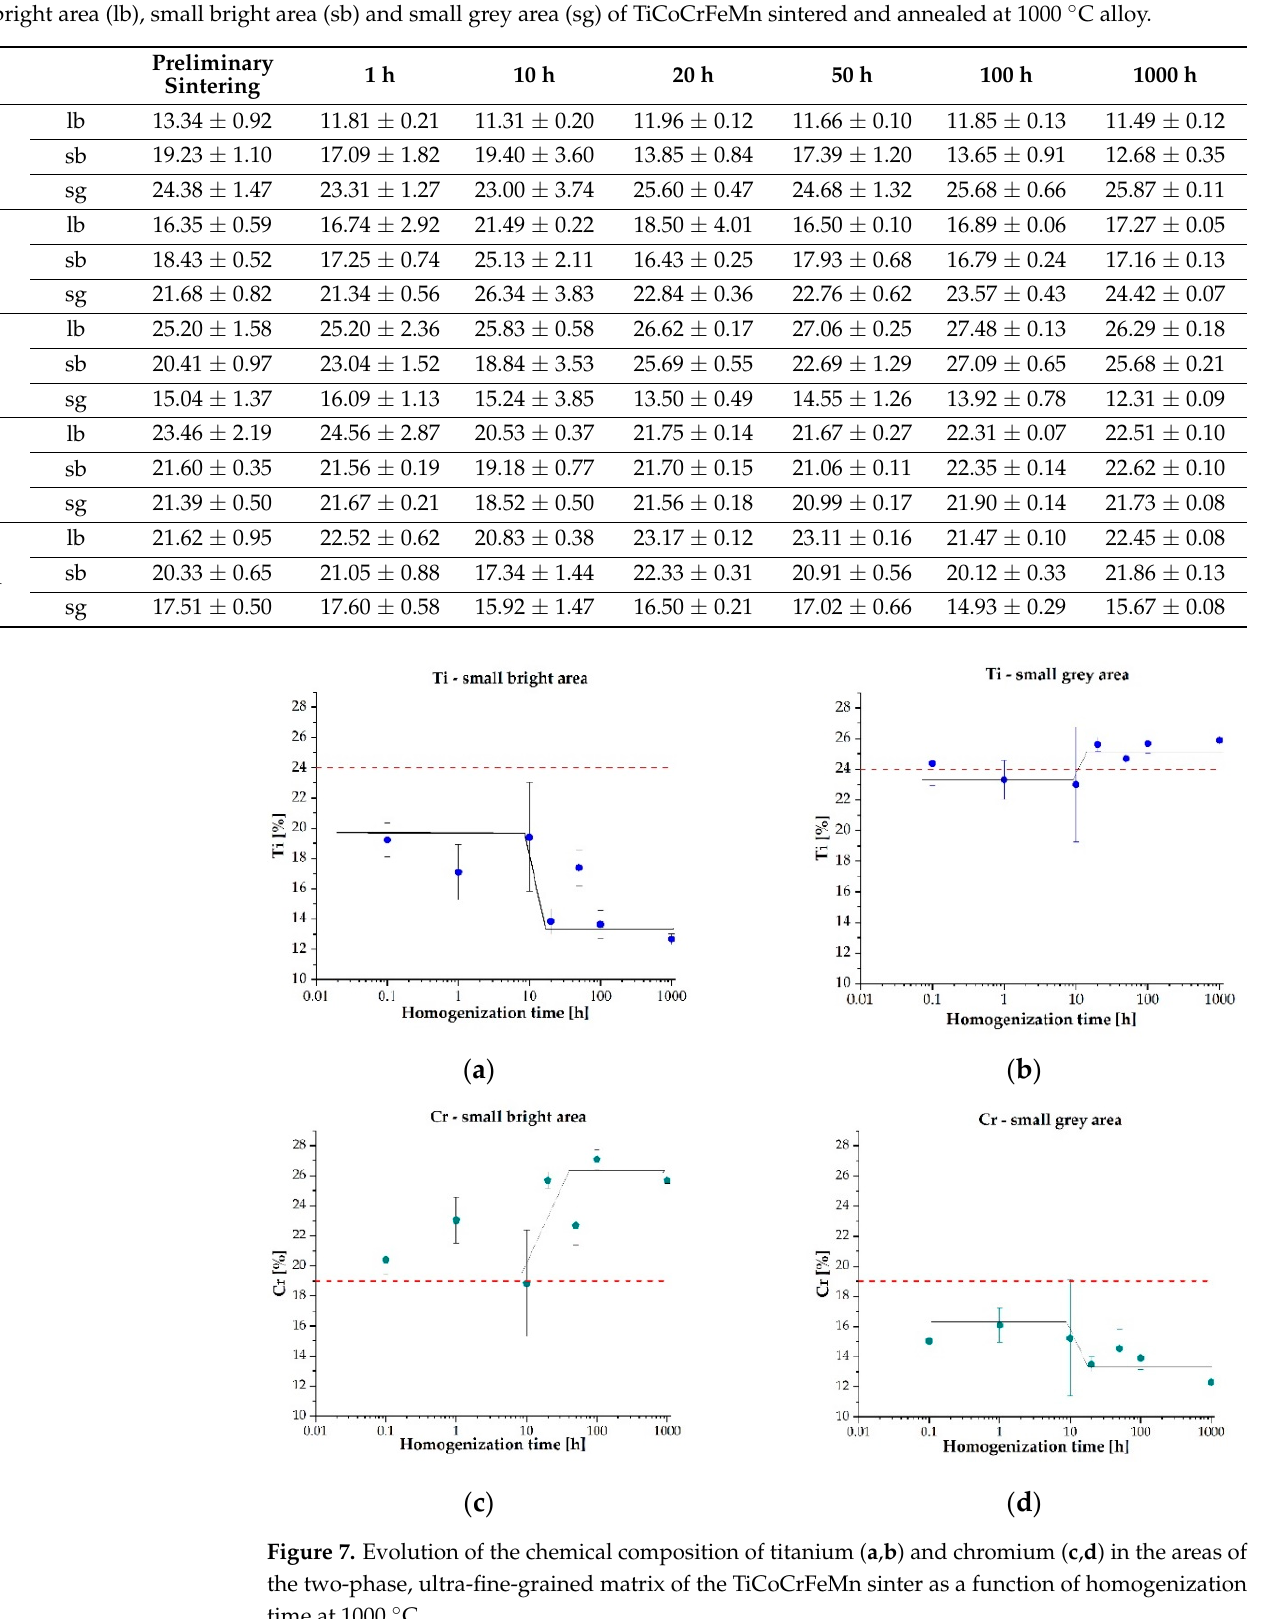
Figure 7. Evolution of the chemical composition of titanium ( a , b ) and chromium ( c , d ) in the areas of the two-phase, ultra-fine-grained matrix of the TiCoCrFeMn sinter as a function of homogenization time at 1000 °C.